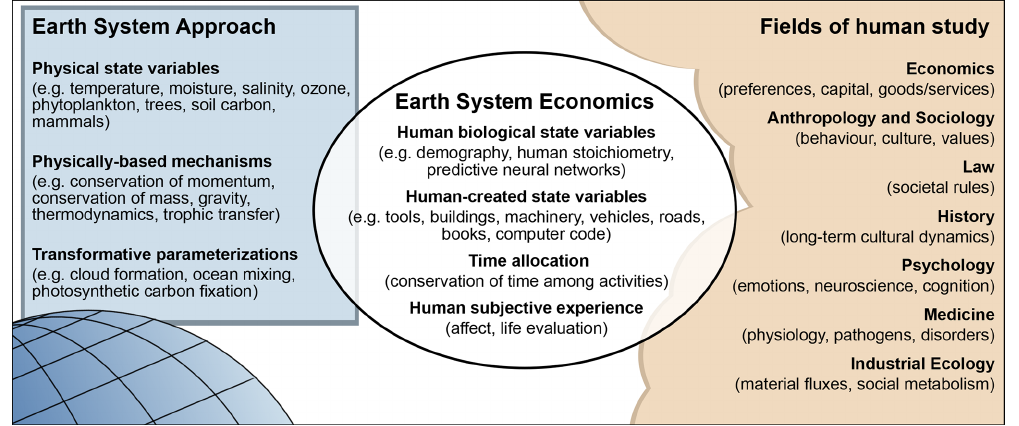
Figure 1. ESE provides a bridge between the Earth system science approach, typified by Earth system models, and the diverse fields of human